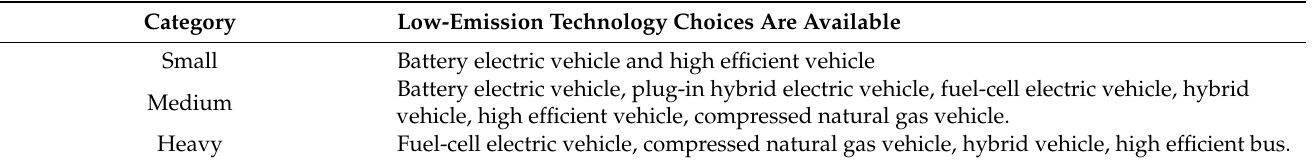
Figure 2. Block diagram of WTW assessment. Table 1. Low-carbon technology solutions in the passenger bus transport sectors.